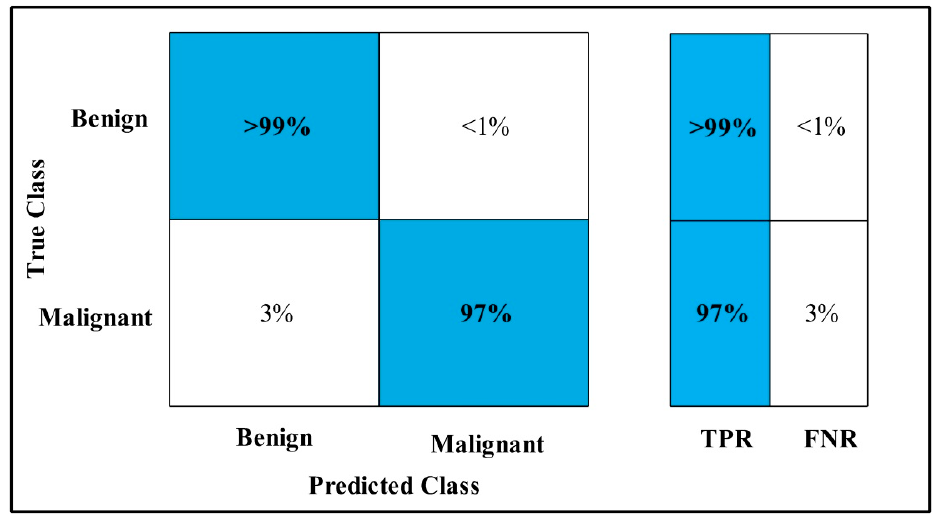
Figure 23. MEWOA on Fine-tuned MobilenetV2 TPR for INbreast.